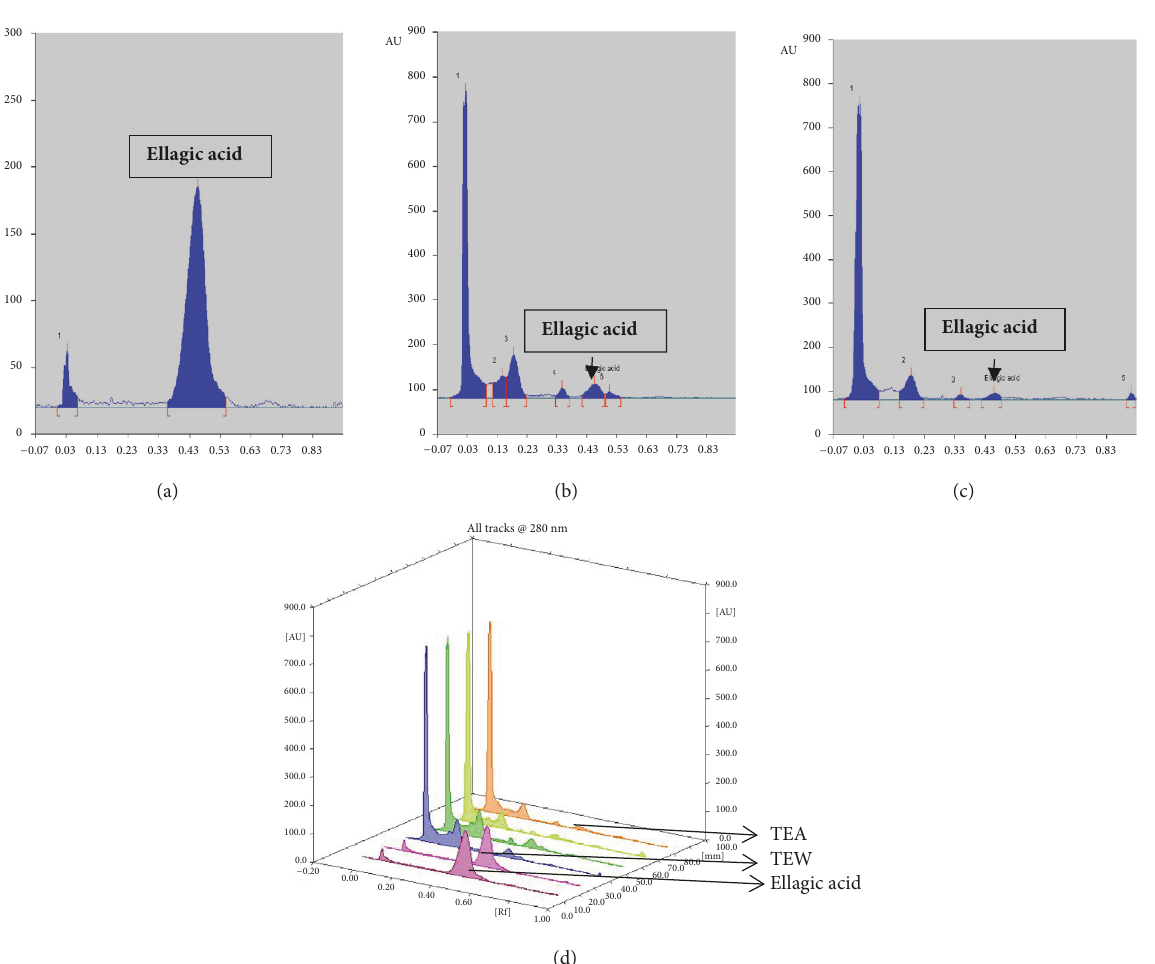
Figure 2: HPTLC profile and chromatograms: (a) ellagic acid; (b) TTE; (c) TTW; (d) chromatogram of ellagic acid, TTE, and